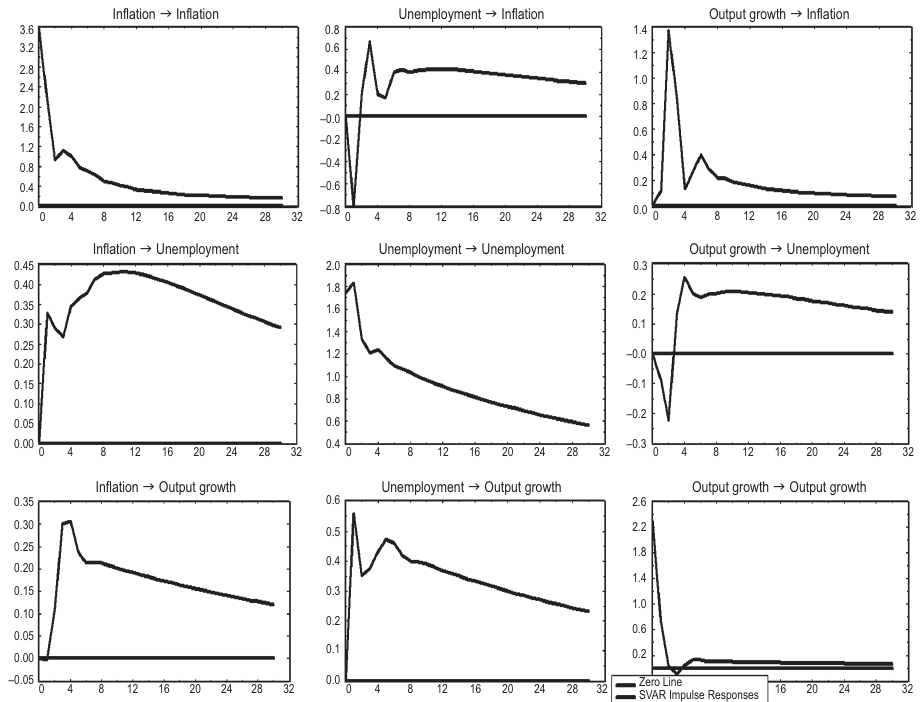
Fig. 2. SVAR impulse response of inflation/unemployment/output Source: author